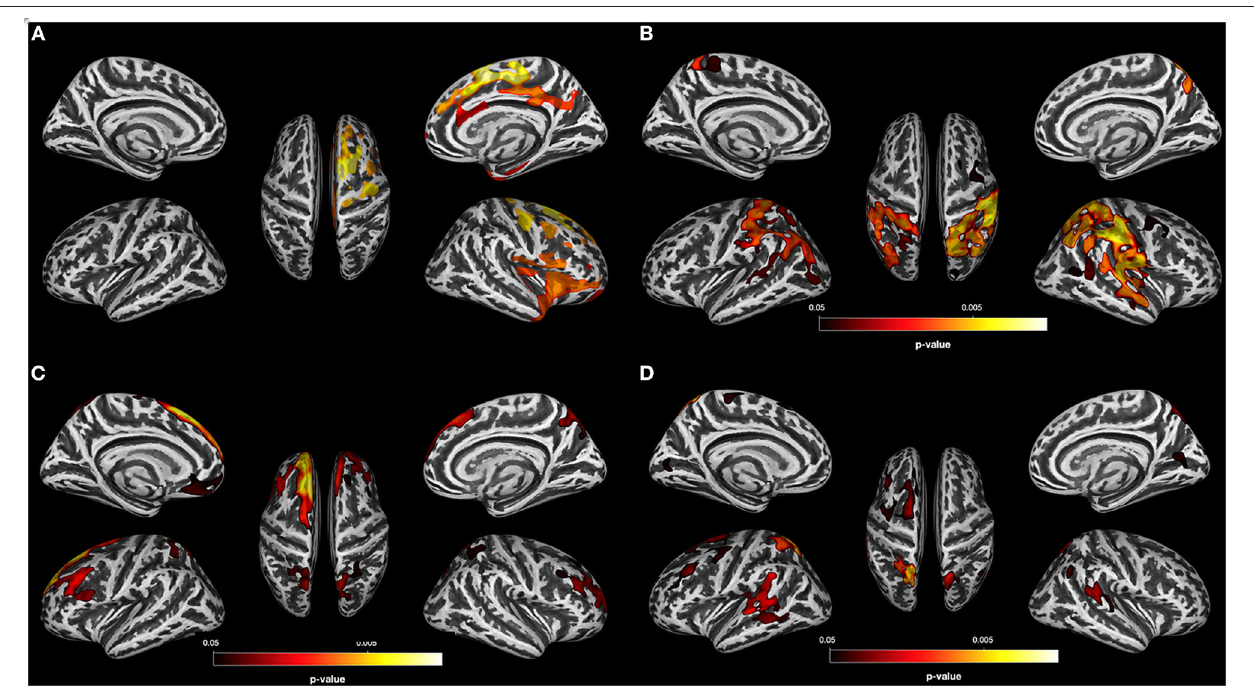
FIGURE 3 | Results for PSU individuals. (A) Result of the data-driven vertex-wise cortical thickness (CT) analysis—controls have significantly higher CT values than polysubstance use disorder individuals (PSU) at p = 0.05 uncorr. (TFCE). (B) Result of the vertex-wise regression analysis—CT clusters in PSU with significant positive correlations with the BIS 11 subscore “High Attentional Impulsivity” at p < 0.05 FWE corr. (TFCE). (C) Result of the data-driven vertex-wise CT analysis—PSU have significantly higher CT values than alcohol use disorder individuals (AUD) at p = 0.05 FWE corr. (TFCE). (D) Result of the data-driven vertex-wise CT analysis—PSU have significantly higher CT values than opioid use disorder individuals (OUD) at p = 0.05 FWE corr. (TFCE).